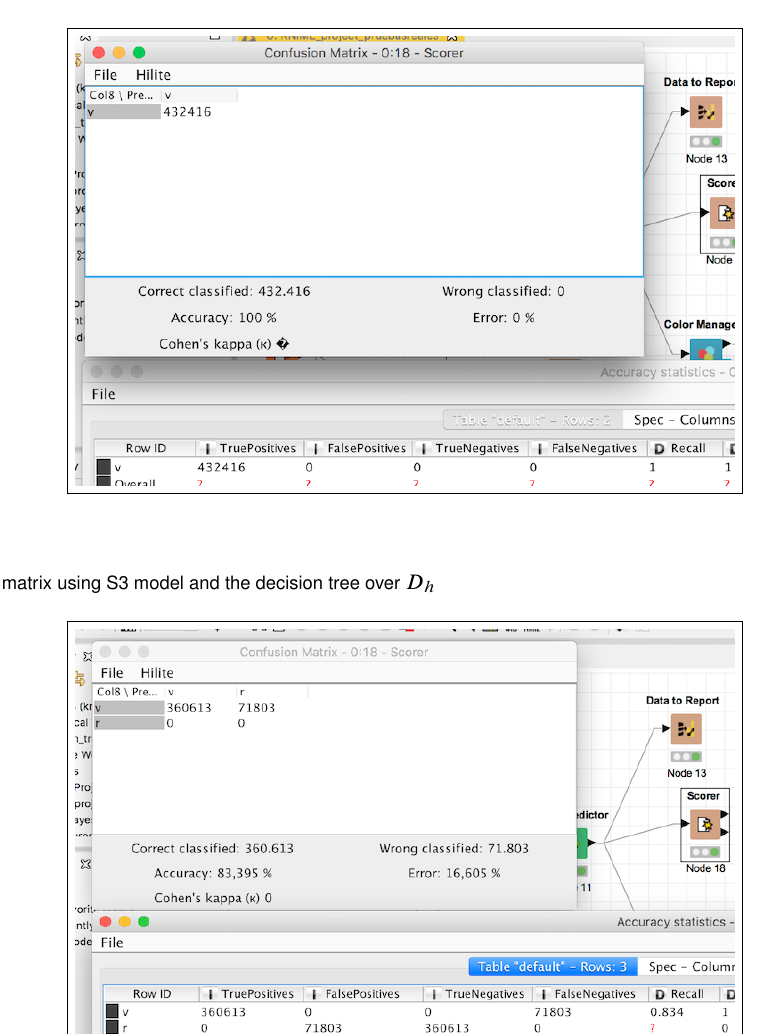
Fig. 8. Confusion matrix using S5 model and the decision tree over a harmless dataset, D h